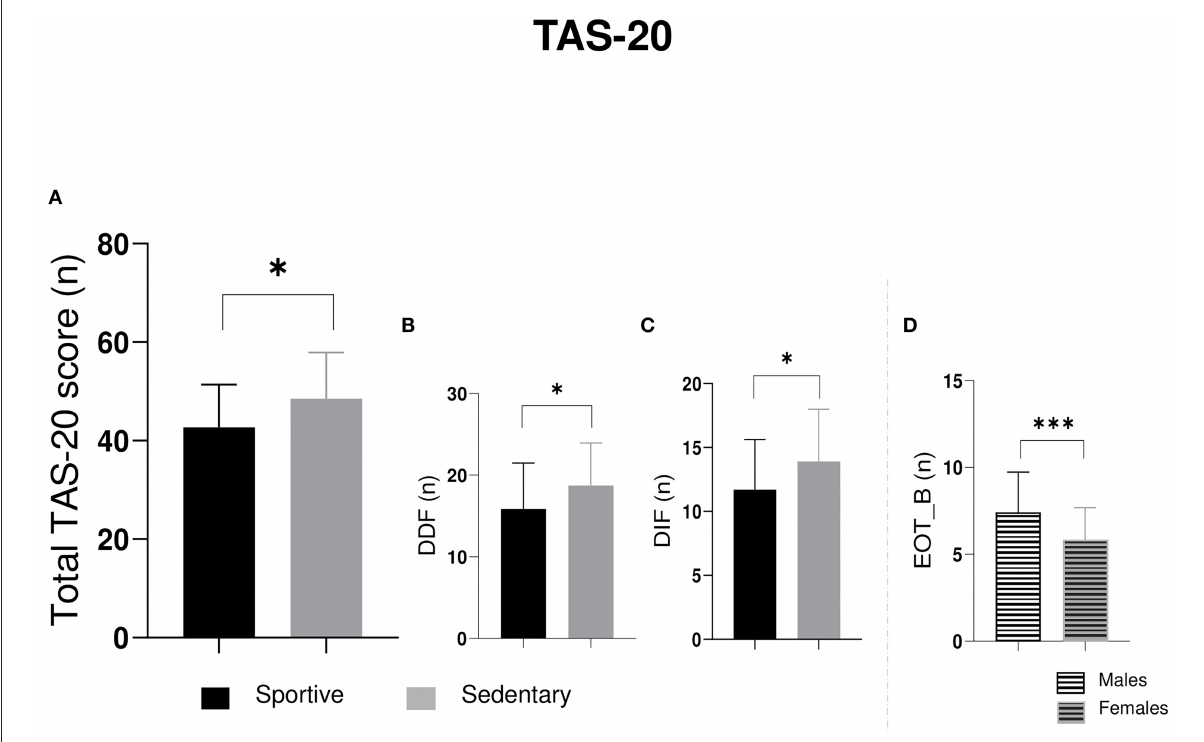
FIGURE3 The 2 x 2 ANOVA significant outputs on (A) total TAS-20 score, (B) DIF factor, (C) DDF factor, and (D) EOT_B factor. DIF, difficulty identifying feelings; DDF, difficulty describing feelings; EOT, external-oriented thinking. * p ≤ 0.05; *** p ≤